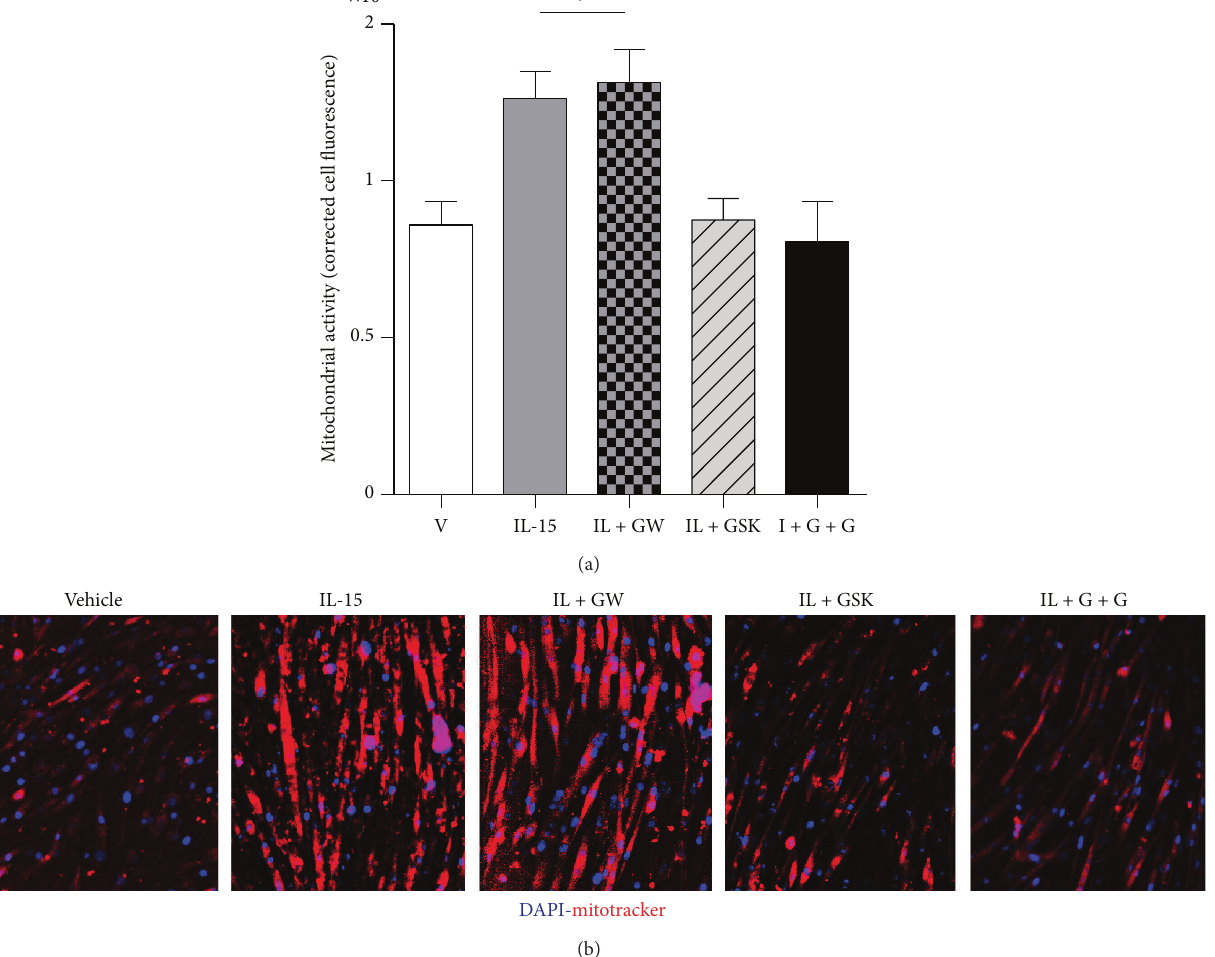
Figure 7: Involvement of PPAR 𝛼 and PPAR 𝛿 in IL-15 mediated mitochondrial activity in live cells. (a) Quantifiable fluorescence corrected for myotube size. Assessments were carried out on differentiated C2C12 myotubes following treatment with vehicle control (DMSO), IL-15 (100ng/mL), IL-15 + GW-6471 (I + GW), IL-15 + GSK-3787 (I + GSK), and IL-15 + GW + GSK (I + G + G) every other day for 6 days during the differentiation protocol. (b) Representative images of mitochondrial activity assessment in live cells using a fluorescent probe sequestered into active mitochondria; Image J was used to quantify cell fluorescence. All values are displayed as means ± SEM, 𝑛 = 6 per group, ∗ different from all groups; 𝑃 < 0.05